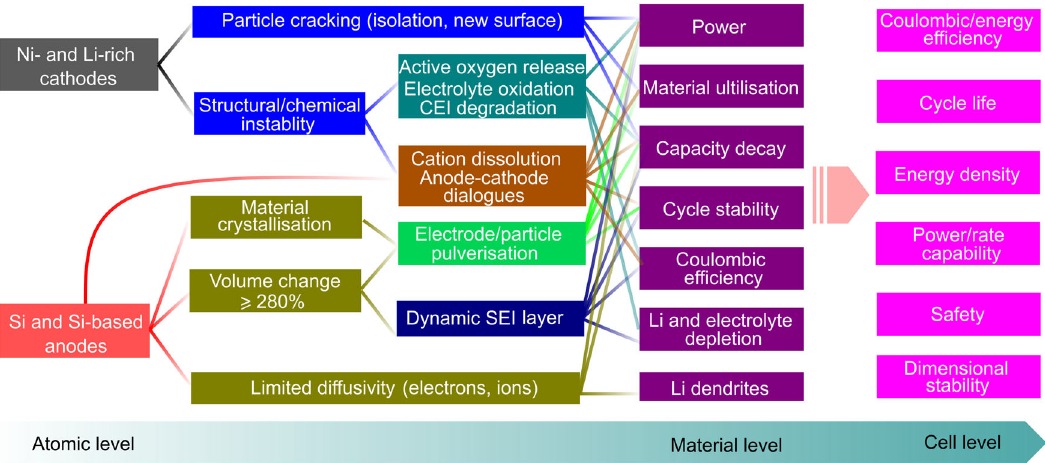
Fig. 5 Correlation between the cell-level performance and atomic/material-level properties for high-energy Si/Si-B/Si-D||IC cells. The main indicators for cell-level performance (e.g. Coulombic/energy ef fi ciency, cycle life, energy density, power/rate capability, safety, dimensional stability) are displayed based on the features of the electrode materials (e.g. power, material utilisation, capacity decay, cycling stability, Coulombic ef fi ciency, Li and electrolyte depletion and Li dendrites). Furthermore, the atomic-level properties (e.g. particle cracking, structural/chemical instability, material crystallisation, volume change and limited diffusivity) that are responsible for the fundamental properties at the material level are